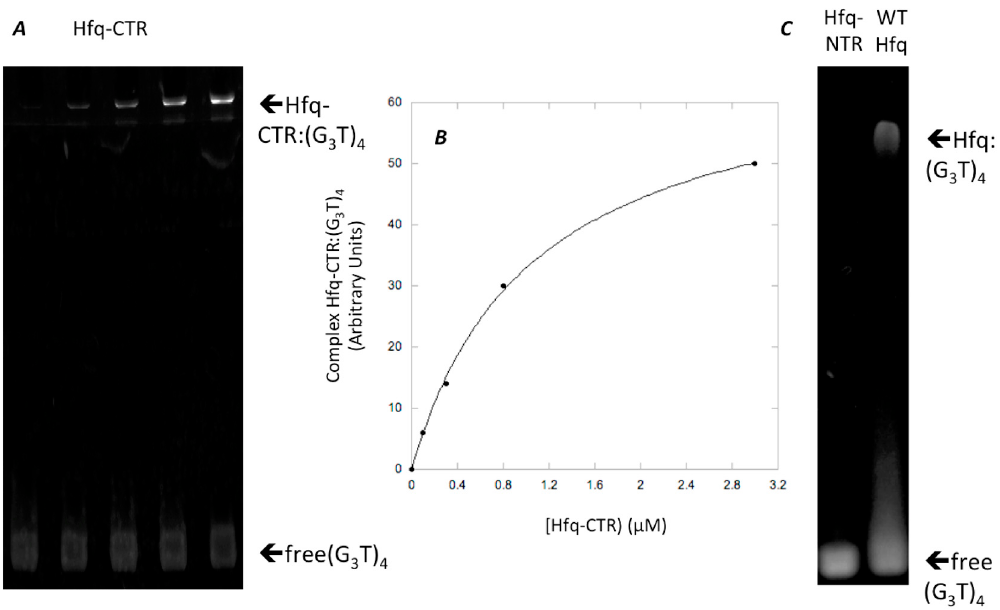
Figure 2. Hfq Binding to (G 3 T) 4 . ( A ) Hfq-CTR binding to (G 3 T) 4 , (G 3 T) 4 concentration 0.1 µ M, while Hfq-CTR concentration ranged from 0 to 3 µ M. ( B ) Graphic analysis of Hfq-CTR binding to (G 3 T) 4 shown in A. ( C ) controls: Hfq-NTR and wild type Hfq binding to (G 3 T) 4 .